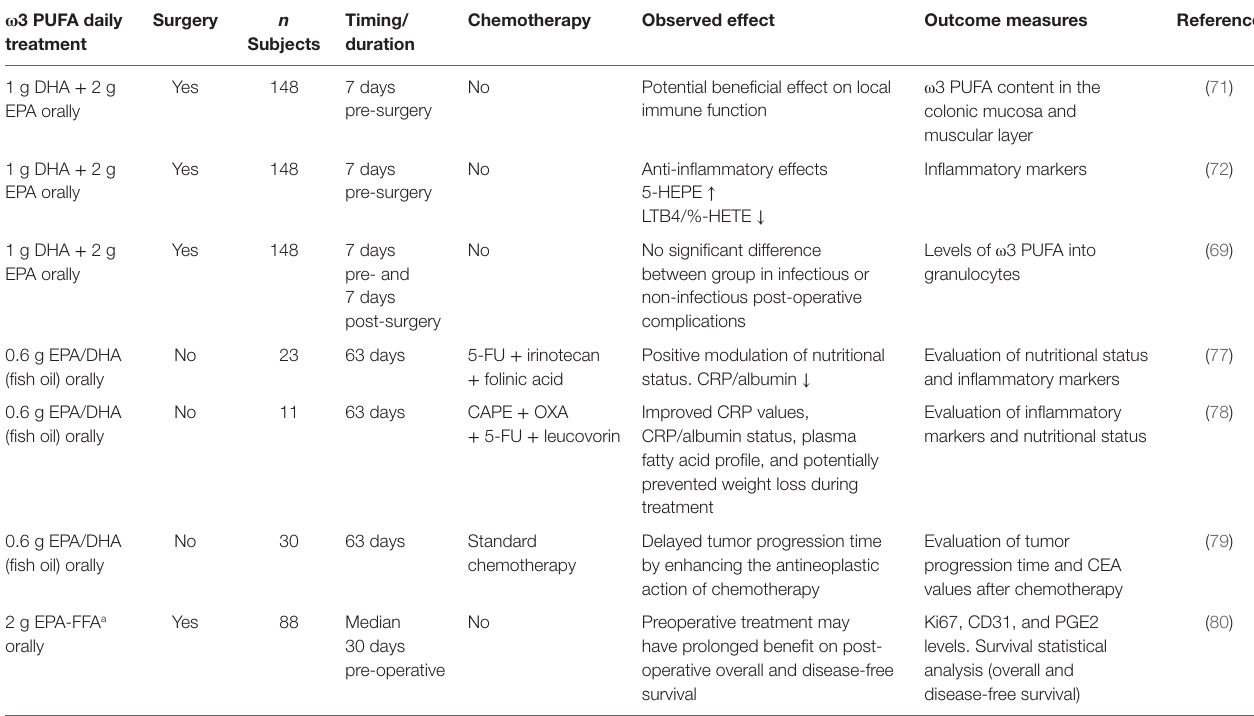
TAbLe 2 | Clinical effects of ω 3 PUFA in CRC